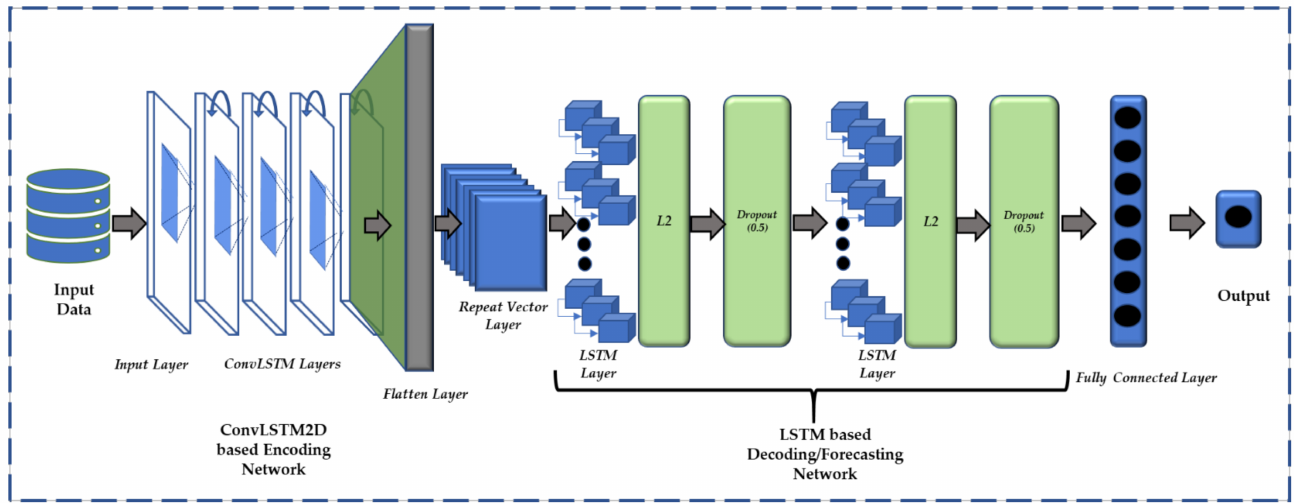
Figure 8. ConvLSTM-LSTM-based encoder–decoder architecture for energy load